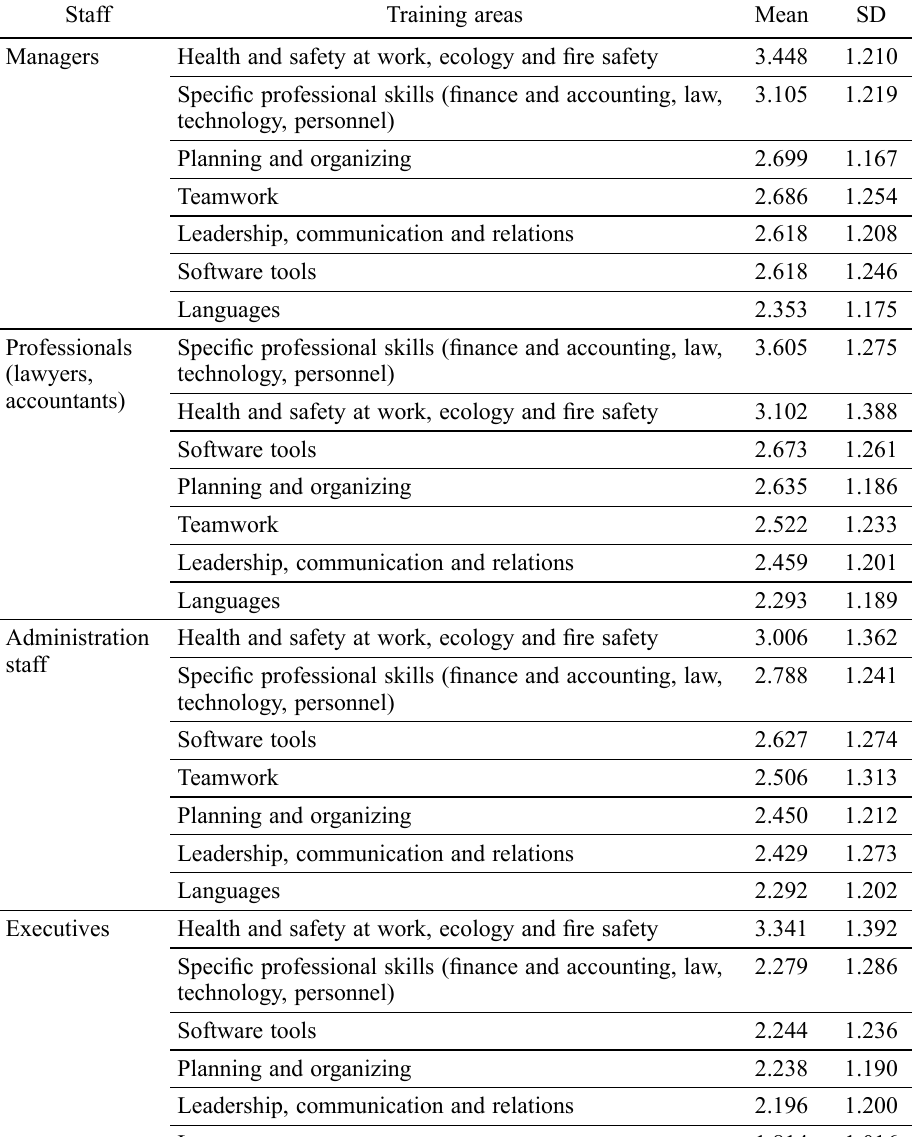
Table 2. The frequency of trainings – mean and standard deviation